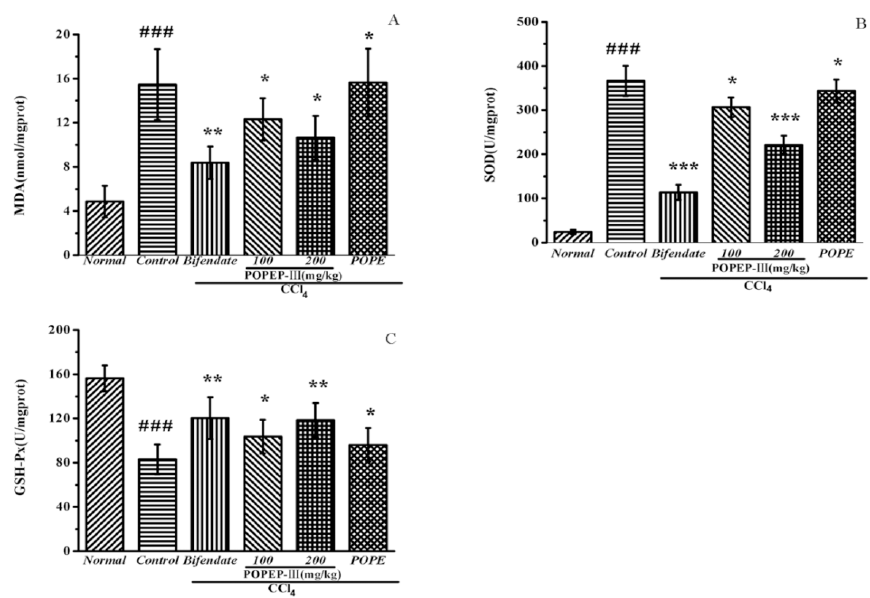
Figure 4. E ff ects of POPEP-III on hepatic MDA ( A ), SOD ( B ) and GSH-Px ( C ) in mice. Values are expressed as the mean values ± SD (n = 7): (###) p < 0.001 compared with normal group; (***) p < 0.001, (**) p < 0.01, and (*) p < 0.05 compared with the CCl 4 -treated control group. Table 7. E ff ects of POPEP-III on hepatic MDA, SOD and GSH-Px in mice. MDA (nmol / mg prot) SOD